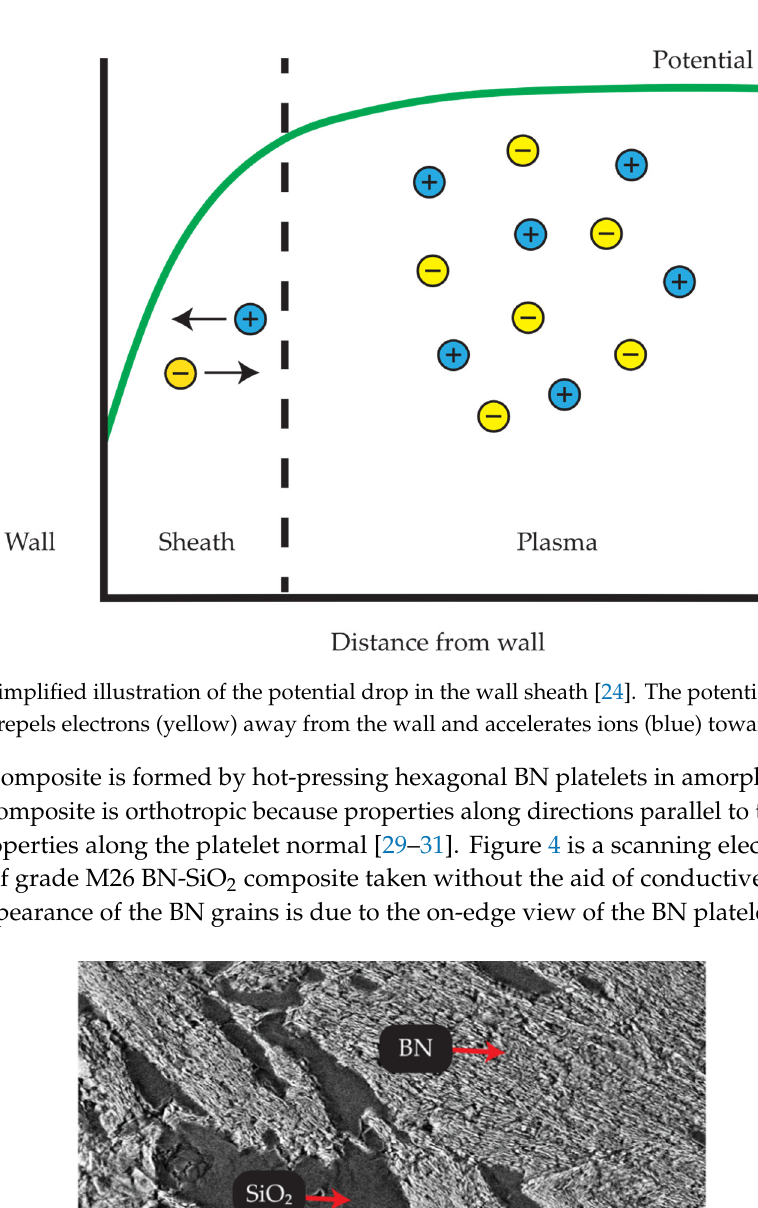
Figure 3. Simplified illustration of the potential drop in the wall sheath [24]. The potential gradient in the sheath repels electrons (yellow) away from the wall and accelerates ions (blue) toward the wall.